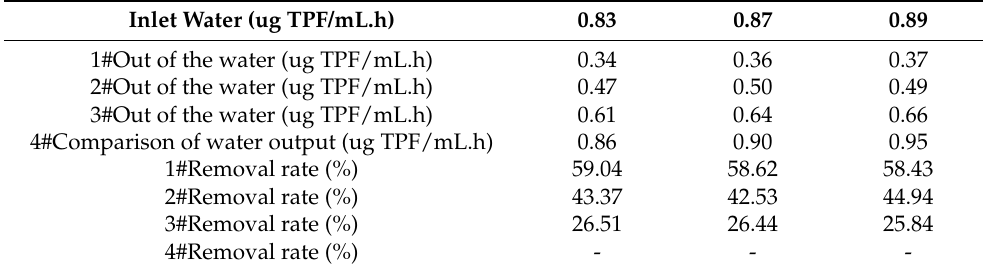
Table 3. The DHA variation in three addition methods with Phanerochaete chrysosporium . Inlet Water (ug TPF/mL.h)